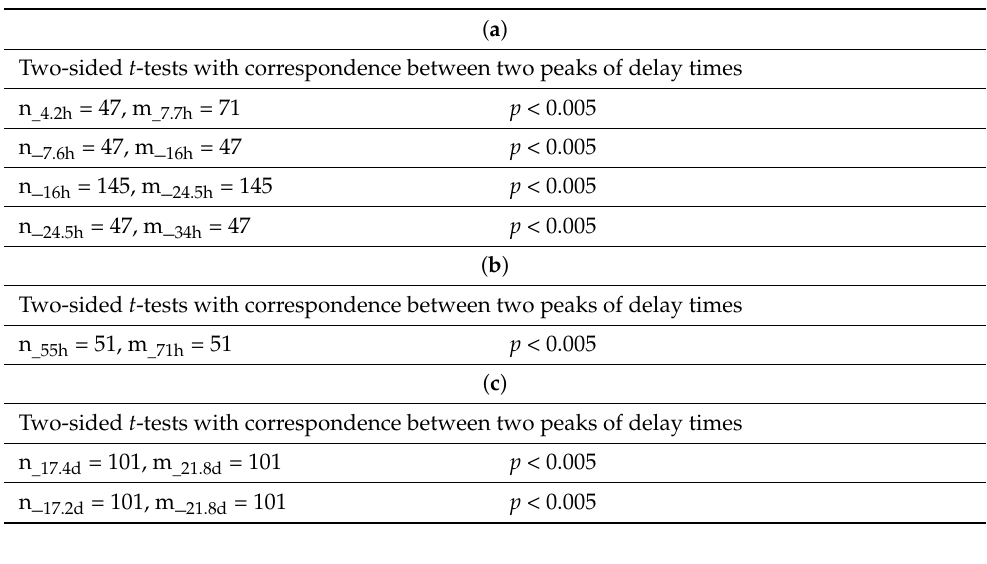
Table A2. Two-sided t -tests with correspondence between two peaks of delay times.